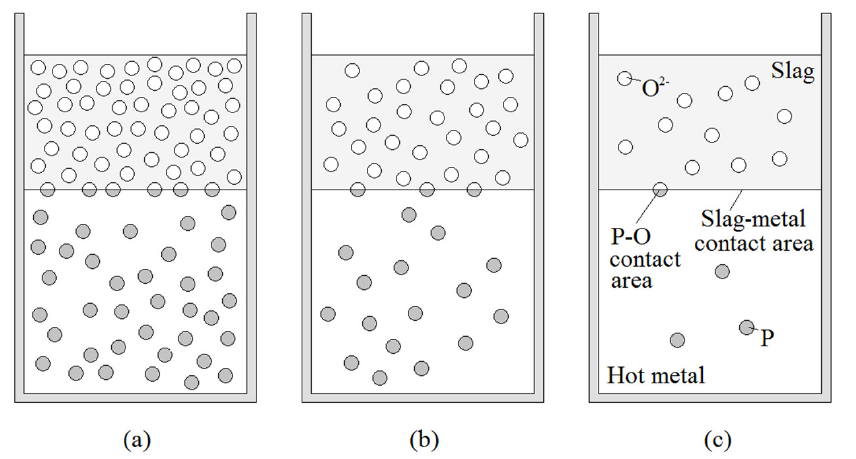
Figure 1. Relationship between P–O contact area and hot-metal phosphorus content with time. (( a ) Initial stage, ( b ) middle stage, ( c ) final stage).